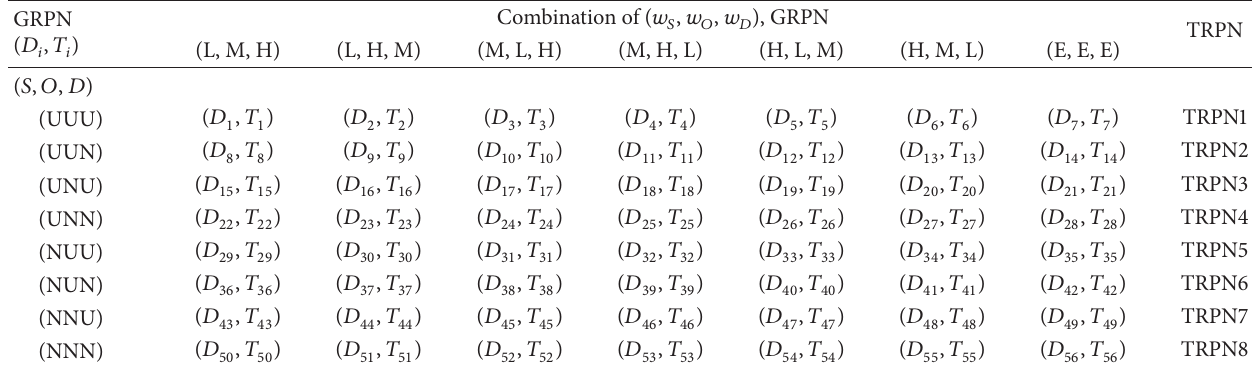
Table 3: Possible combination of the risk factors and weights.